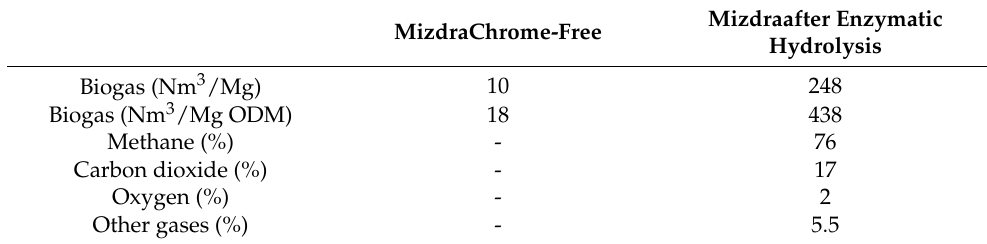
Table 3. Parameters of different kinds of leather shavings. MizdraChrome-Free